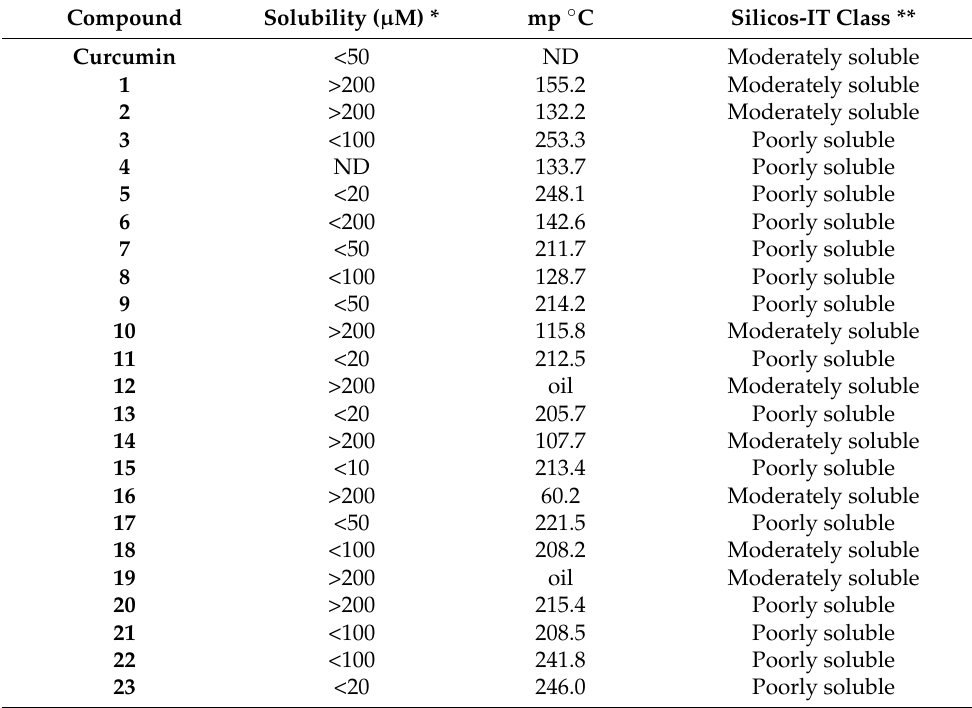
Table 3. Solubility and melting points of 1,5-Benzodiazepin-2(3 H )-ones.